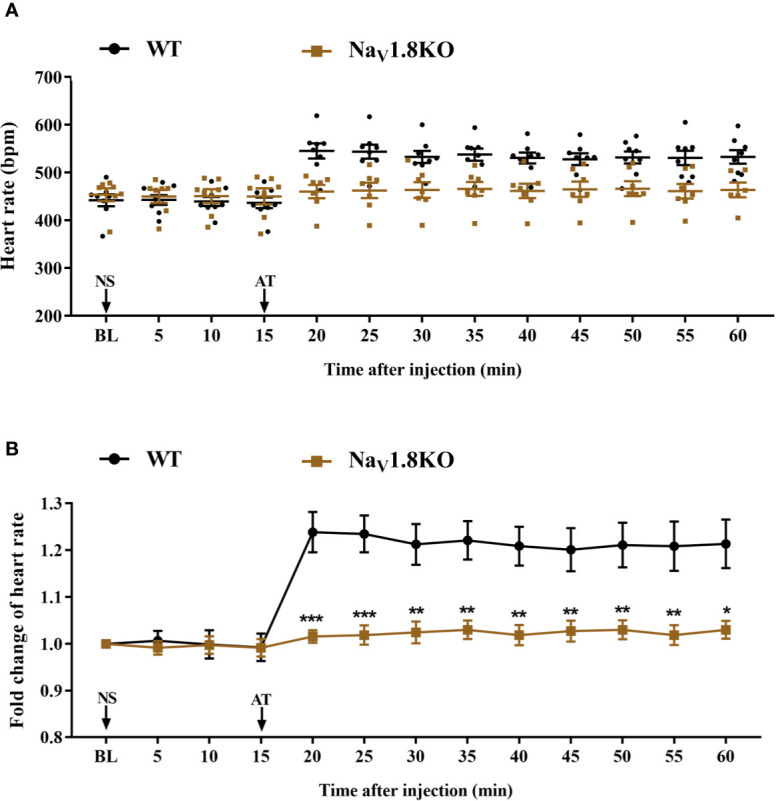
The heart rate response of atropine in NaV1.8 knockout mice. (A) Scatter diagram of heart rate after atropine treatment. (B) Line diagram of fold change of heart rate after atropine treatment. Heart rate was normalized to the value of baseline heart rate for each group. *p < 0.05, **p < 0.01, ***p <0.001 vs wild type mice. WT, wild type; KO, knock out; NS, normal saline; AT, atropine; BL, baseline.